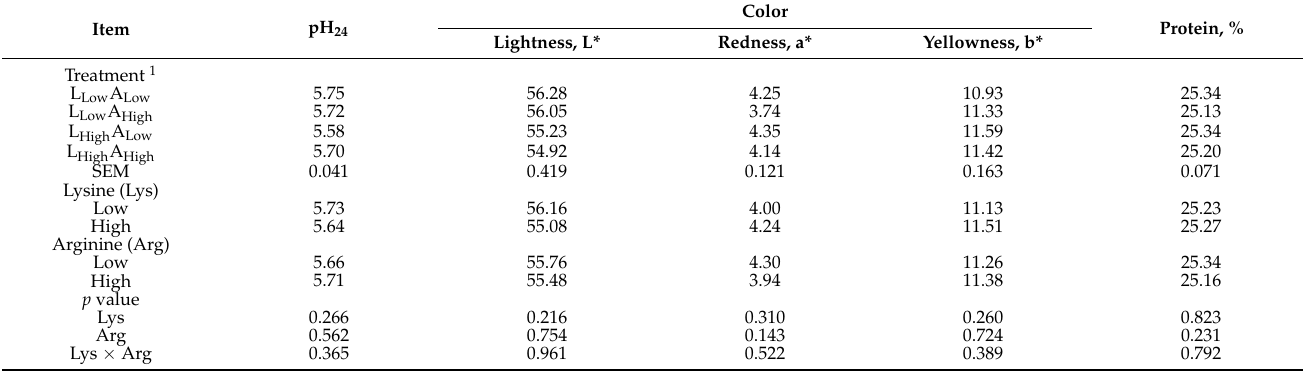
Table A3. The effect of diets differing in Lys and Arg content on the physicochemical properties of breast meat in turkeys at 16 weeks of age. Item pH 24